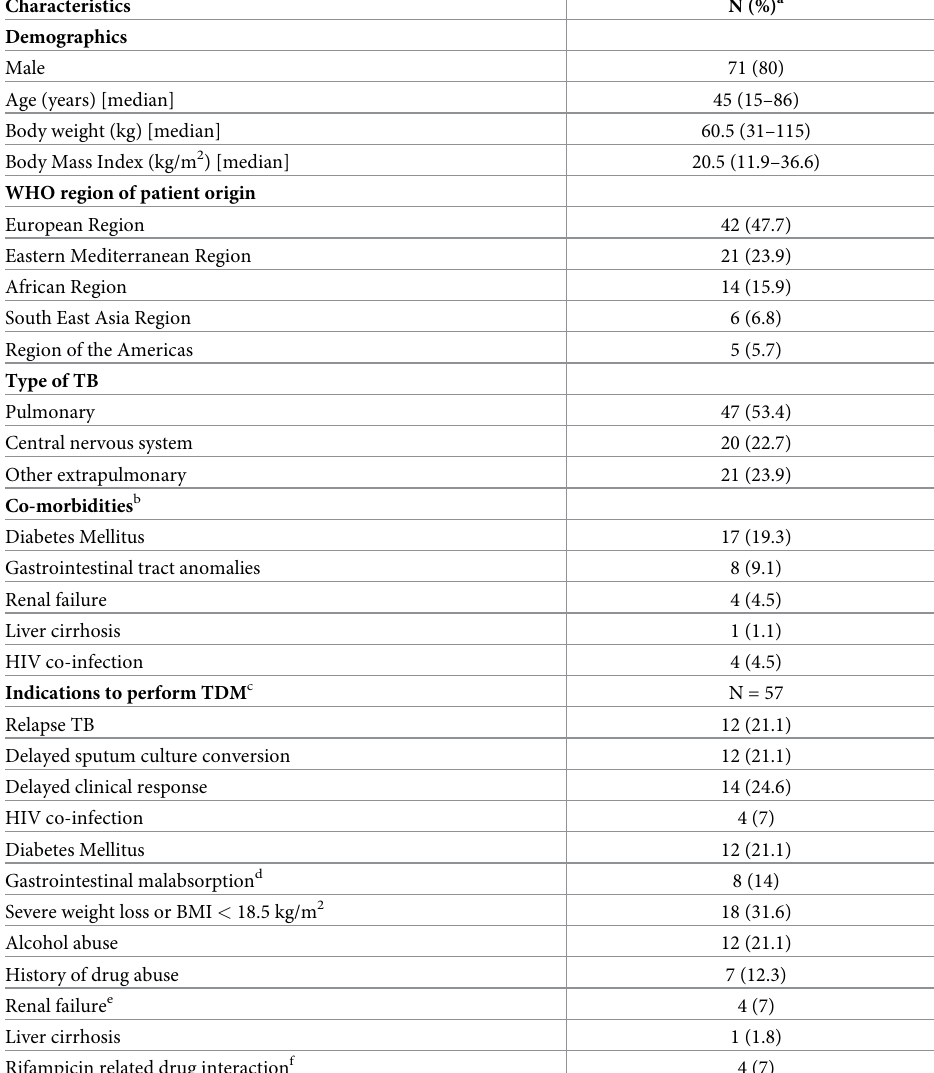
Table 1. Characteristics of TB patients treated with high-dose rifampicin (n = 88).